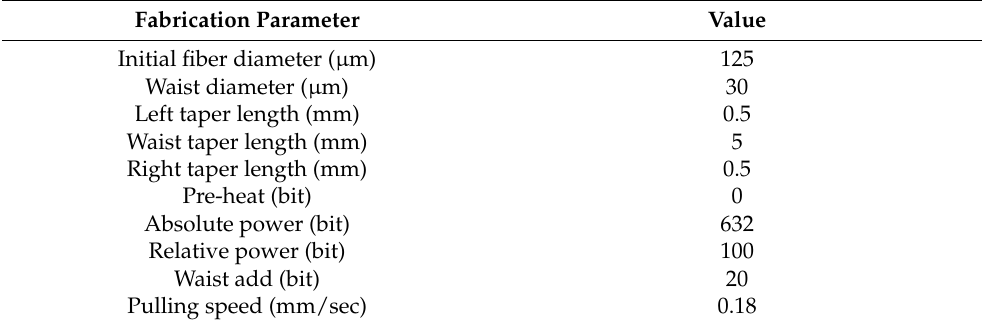
Table 1. Input parameters for fabrication of shallow-tapered chirped fiber Bragg